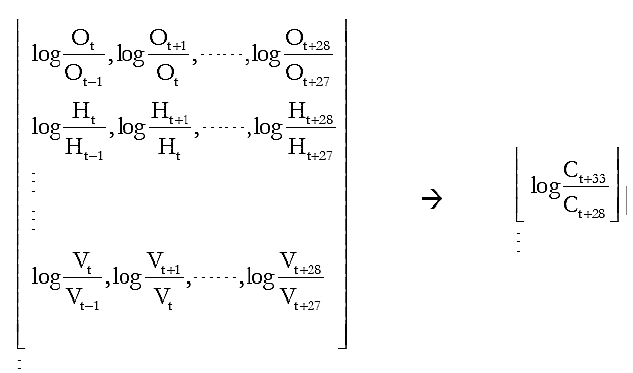
Fig. 8. Logarithmic return based on the window length and predict length.